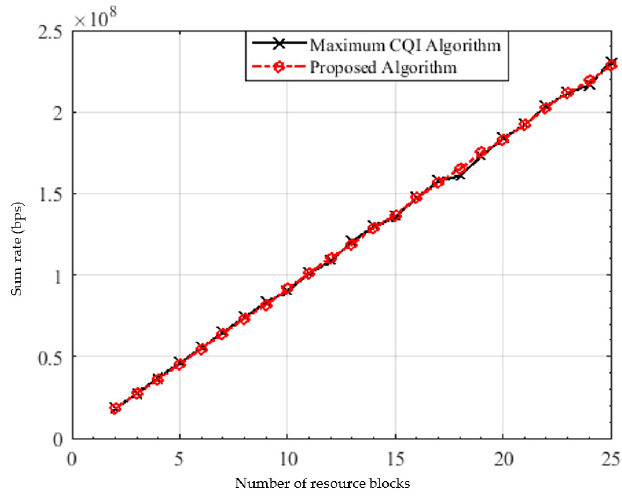
Figure 9. Sum rate versus the number of RBs.